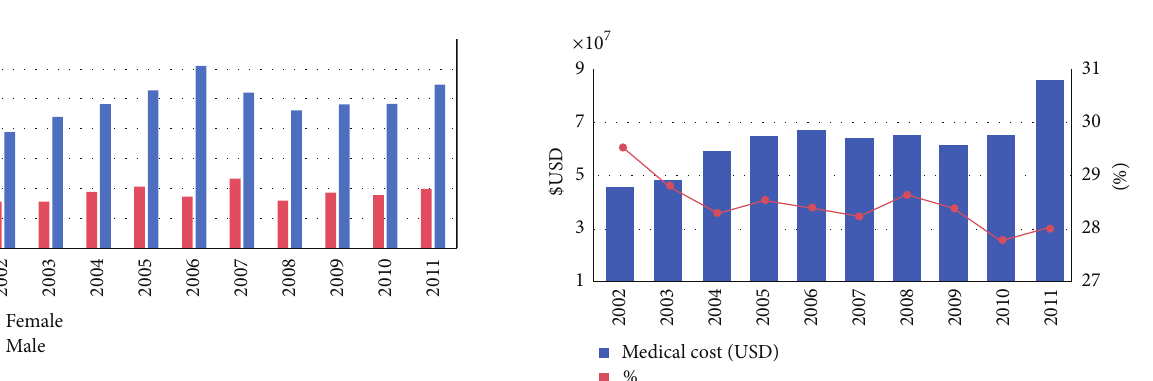
Figure 1: Mortality rates of both genders among the traffic acci- dents-related inpatients in Taiwan, 2002–2011. Figure 2: Trends of direct medical burden of the orthopedic fractures among all the inpatient population in Taiwan,